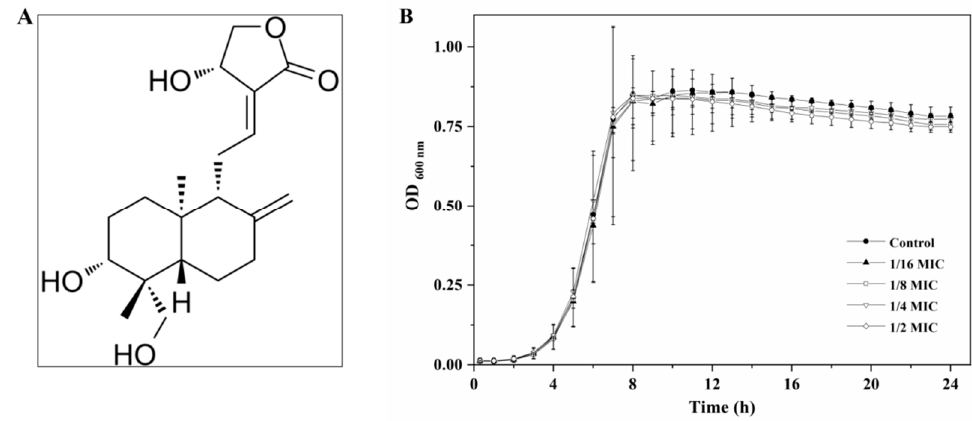
Figure 1. ( A ) Chemical structure of andrographolide and ( B ) growth curves of L. monocytogenes in BHI broth with different concentrations of